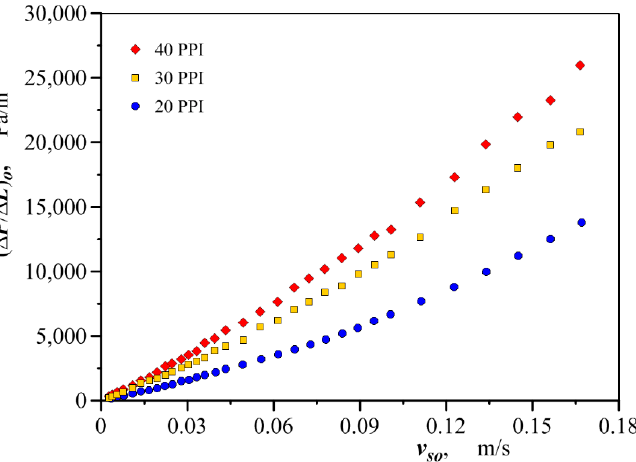
Figure 4. Change in measured pressure drop for water through metal foams as a function of the water velocity.